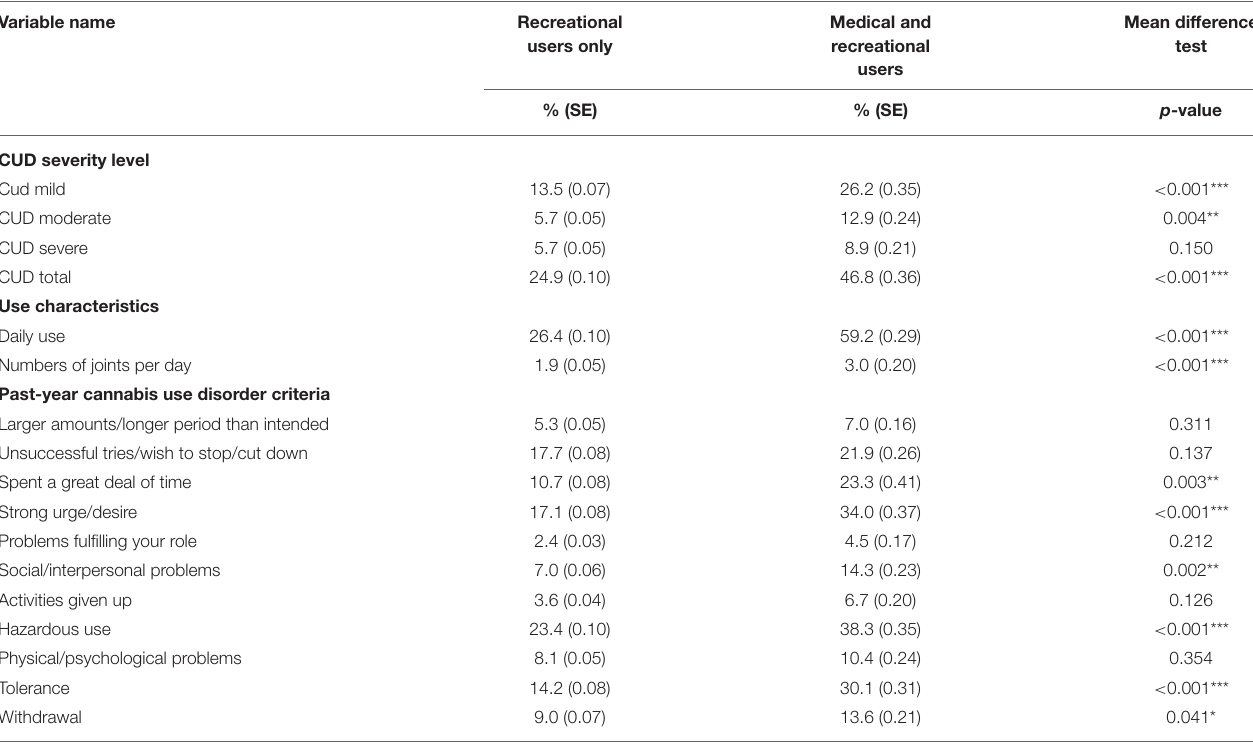
TABLE 2 | Past-year cannabis use disorder (CUD) prevalence, by severity level, and cannabis use characteristics among past-year cannabis users in two population